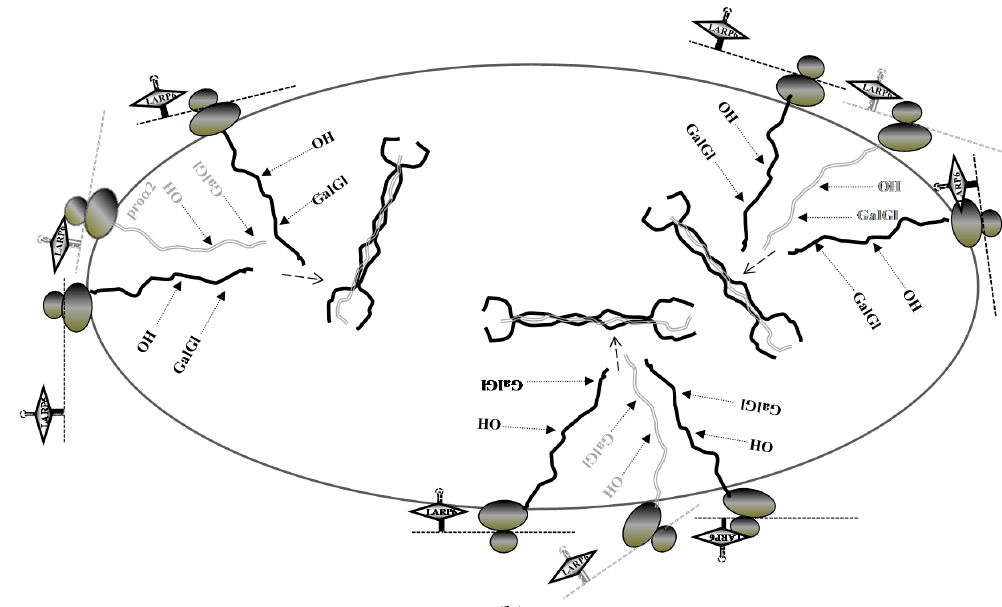
Figure 3. Translation of collagen mRNAs on the membrane of the ER. ( a ) LARP6 independent, constitutive synthesis of type I collagen; ( b ) LARP6 dependent, highly productive synthesis. Collagen mRNAs are shown as thin dashed lines, translating ribosomes as dark ovals, collagen polypeptides as thick lines with posttranslational modifications indicated (OH, proline and lysine hydroxylations, GalGl, glycosylations). Dashed arrows point to folding of the triple helix.